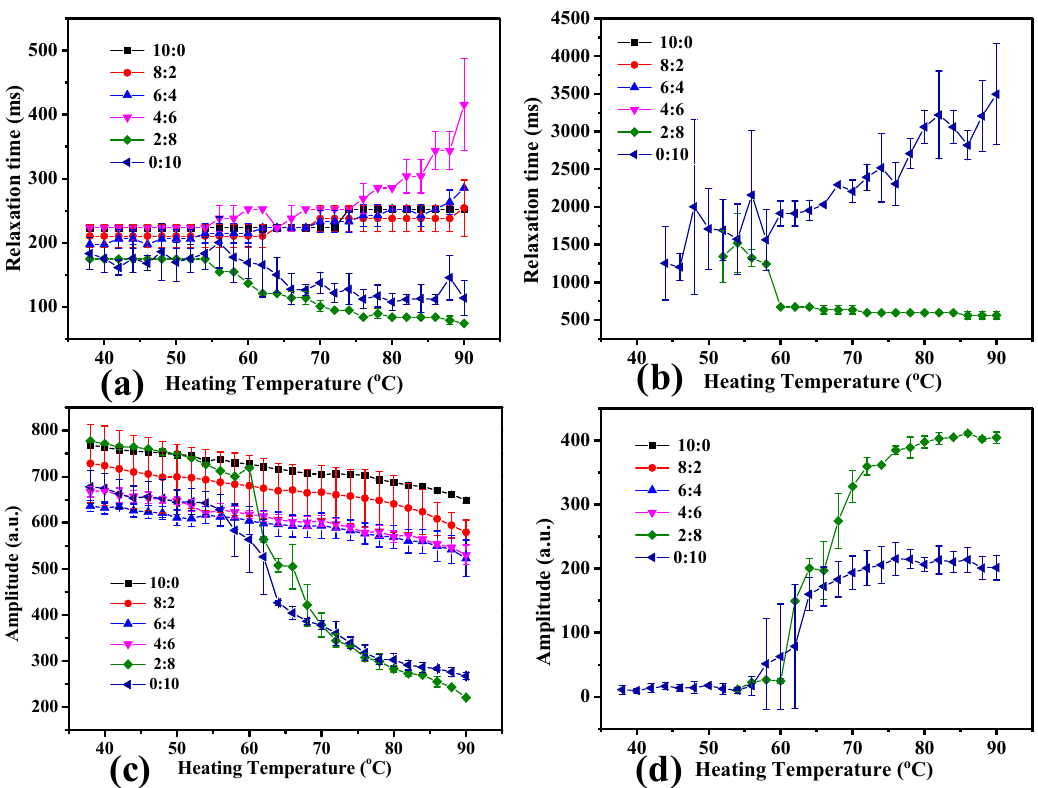
Figure 3. ( a ) T 23 ; ( b ) T 24 ; ( c ) A 23 ; and ( d ) A 24 changes of the SP and MP system during heating from 38 to 90 °C.